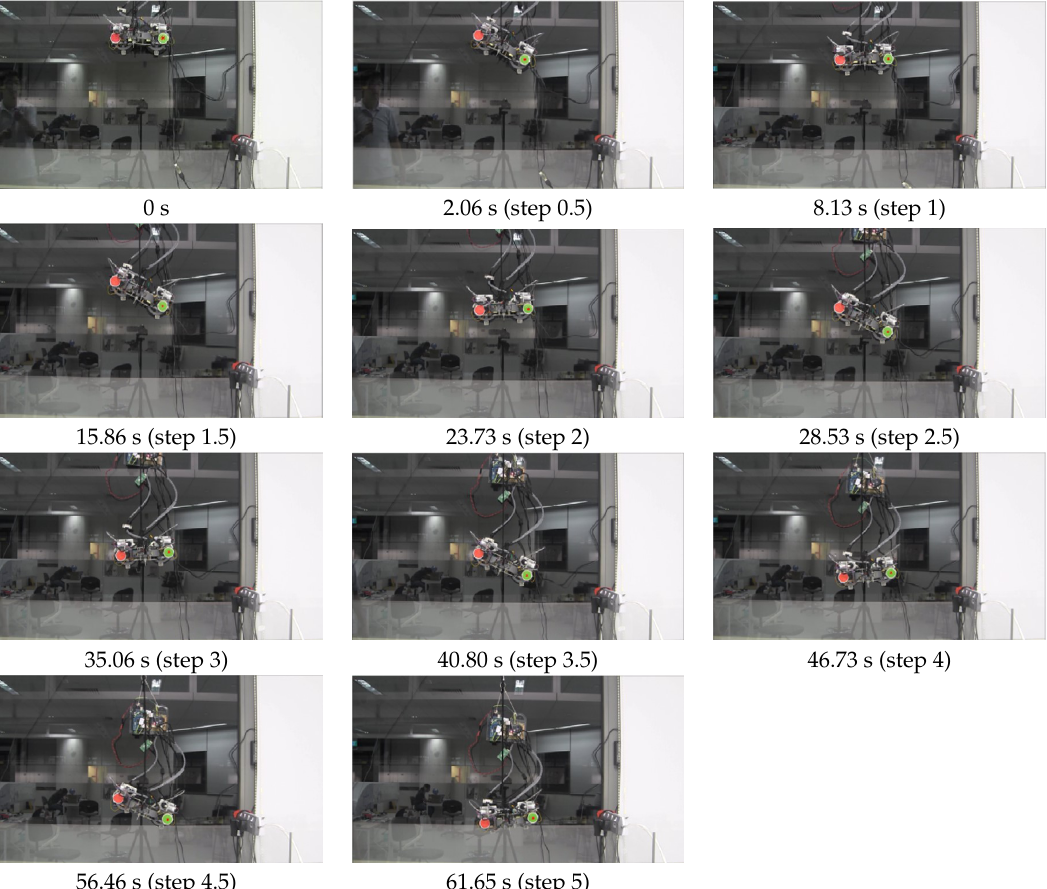
Figure 14. The snapshots of the normal-locomotion experiment with time variation. Five normal locomotions within 61.65 s were realized without any human aid.